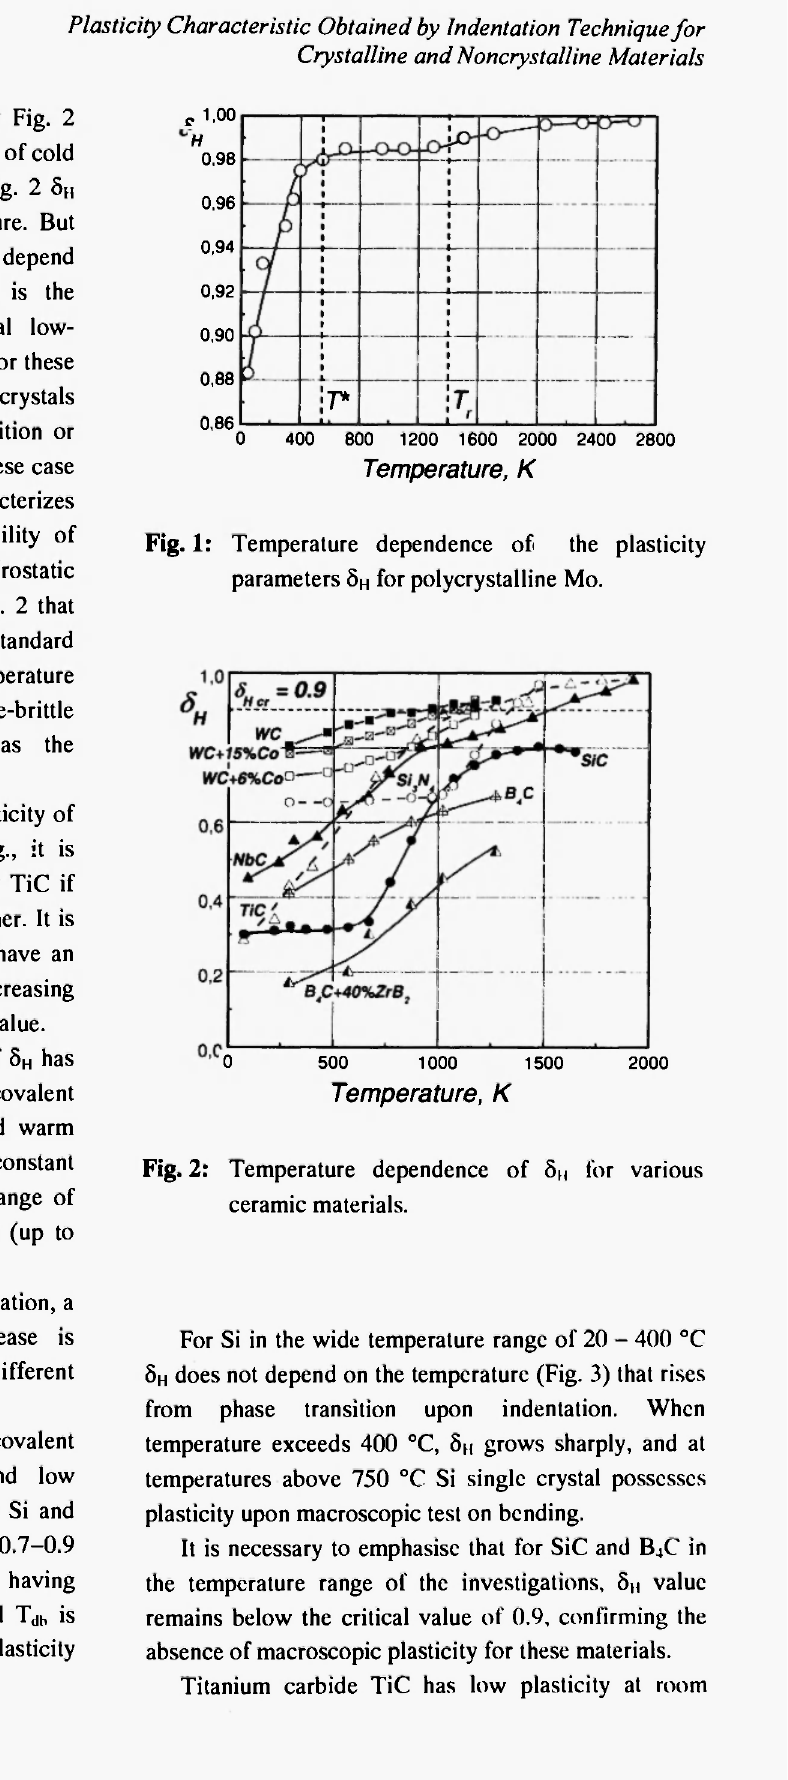
Fig. 1: Temperature dependence of the plasticity parameters δ Η for polycrystalline Mo.